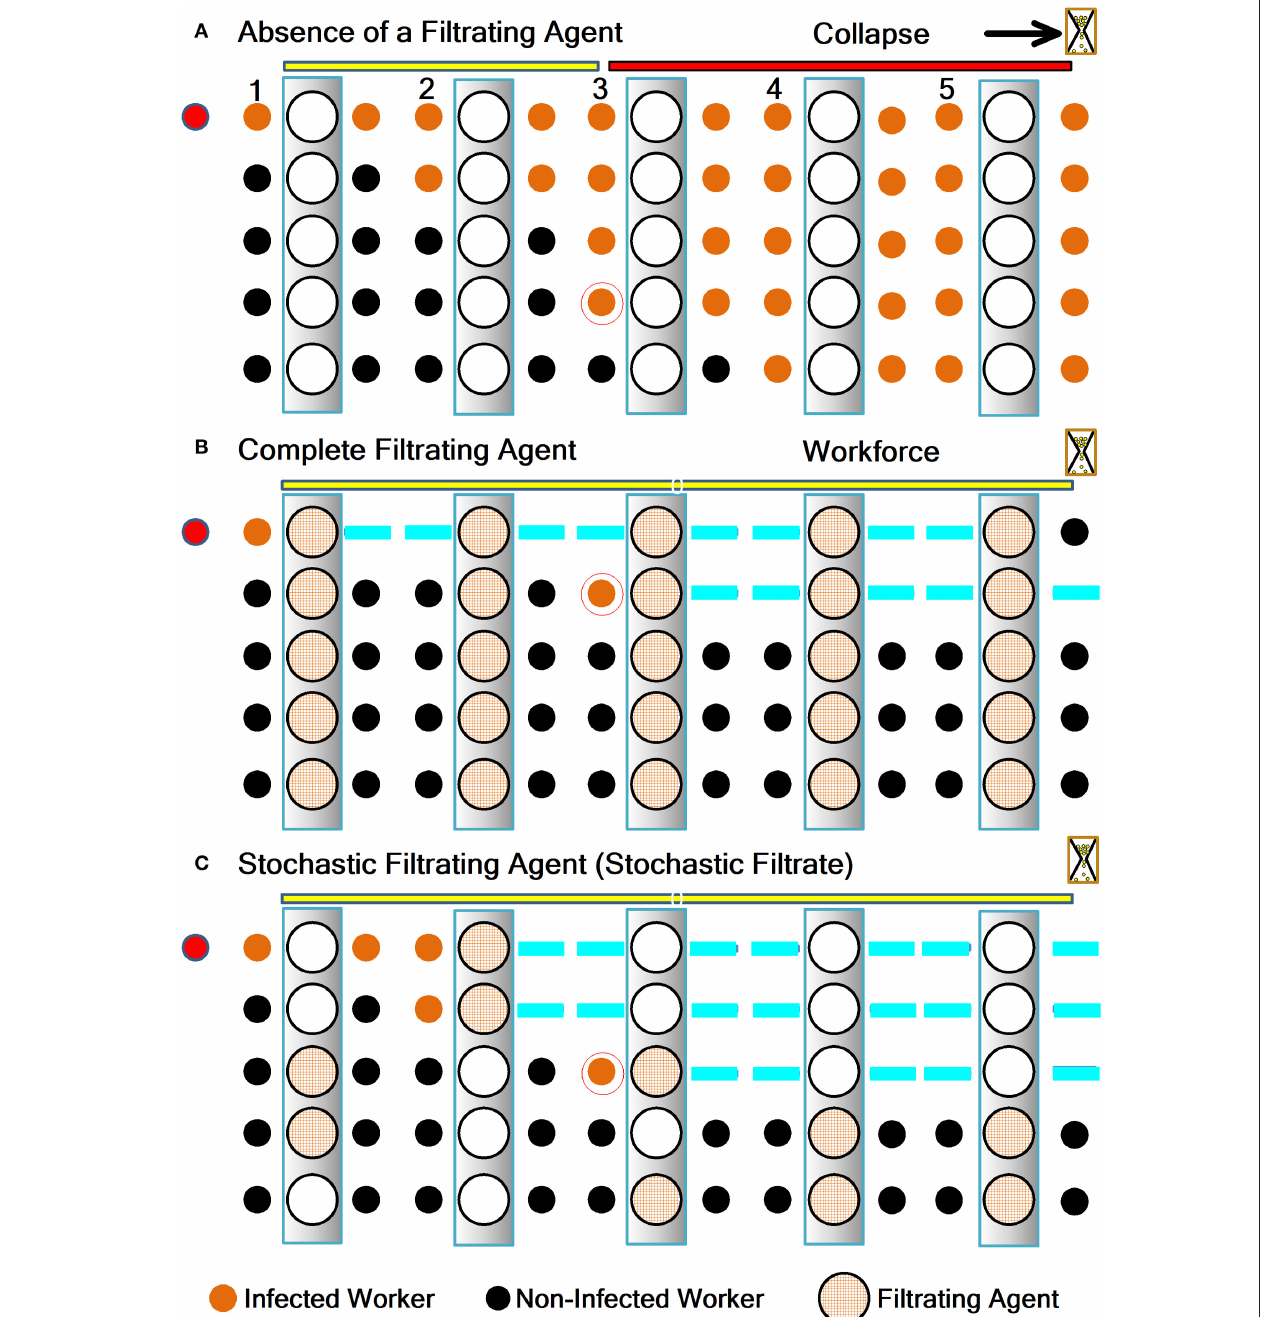
FIGURE 2 | Strategies with real-time-RT-PCR as a filtrating agent, including the stochastic filtrate. (A) There is no filtration process when a filtrating agent is absent. (B) The filtrate is highly effective when there is a complete filtrating agent (real-time-RT-PCR testing for all workers). (C) The case of the stochastic filtrate. Here the infected workers are the “filtride,” and the non-infected workers are the “filtrate.” Note that (C) is similar to Figure 1C , but for infection between workers. The blue line indicates that an infected worker is in quarantine. The filtrating agent randomly selects subjects (see vertical rectangles containing white circles and sieve circles). For this example, the random sampling size (RSS, number of filtrating agents) is two in a population of five complete filtrating agents (i.e., RSS = 40%). Interestingly, when the RSS is equal to the number of complete filtrating agents (100%), then we obtain the scenario illustrated in (B) . However, when the RSS is zero %, we get the situation depicted in (A) . Thus, our method shown in (C) reproduces the three scenarios. RSS is expressed as percentage of the total number of filtrating agents; i.e., when the filter is in the “complete filtrating agent” condition (N = 0 and M = Z, see Methods).